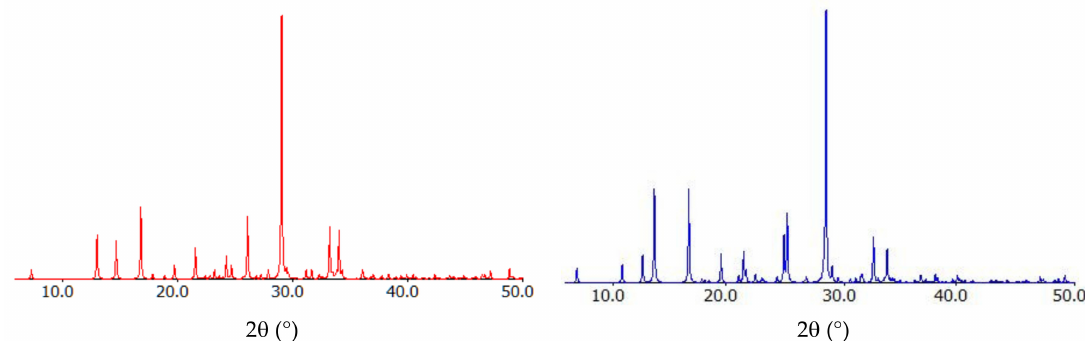
Figure 3. Simulated PXRD patterns for PANLAS (red) and (I)